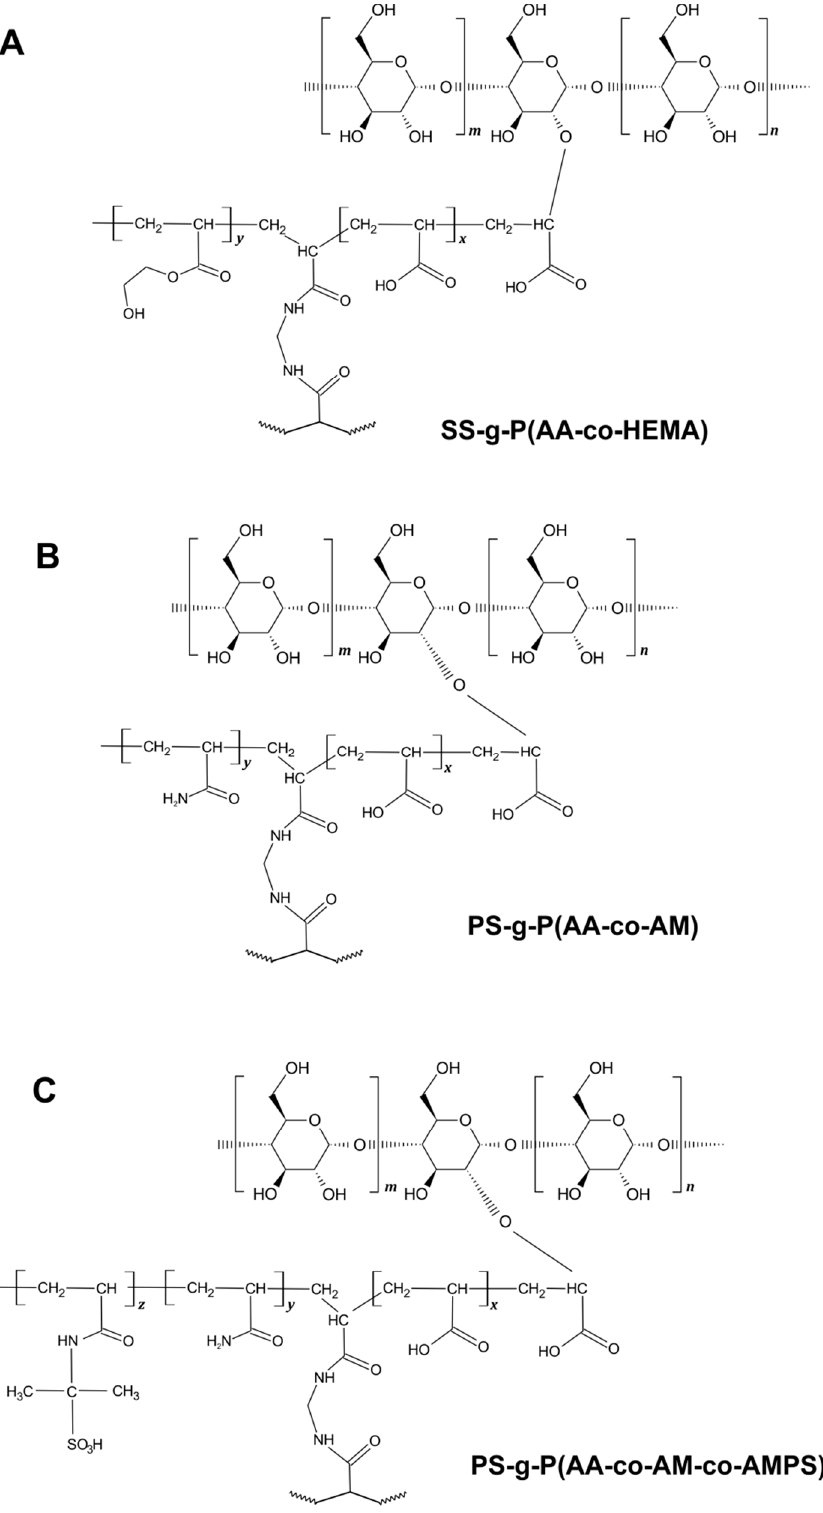
Figure 1. Schematic representation of synthesized grafted starch counterparts of superabsorbent polymers: soluble starch-g-poly(acrylic acid-co-2-hydroxyethylmethacrylate) SS-g-P(AA-co-HEMA) ( A ), potato starch-g-poly(acrylic acid-co-acrylamide) PS-g-P(AA-co-AM) ( B ), and poly(vinyl alcohol)/potato starch-g-poly(acrylic acid-co-acrylamide-co-2-acrylamido-2-methylpropane sulfonic acid) PS-g-P(AA-co-AM-co-AMPS) ( C ).